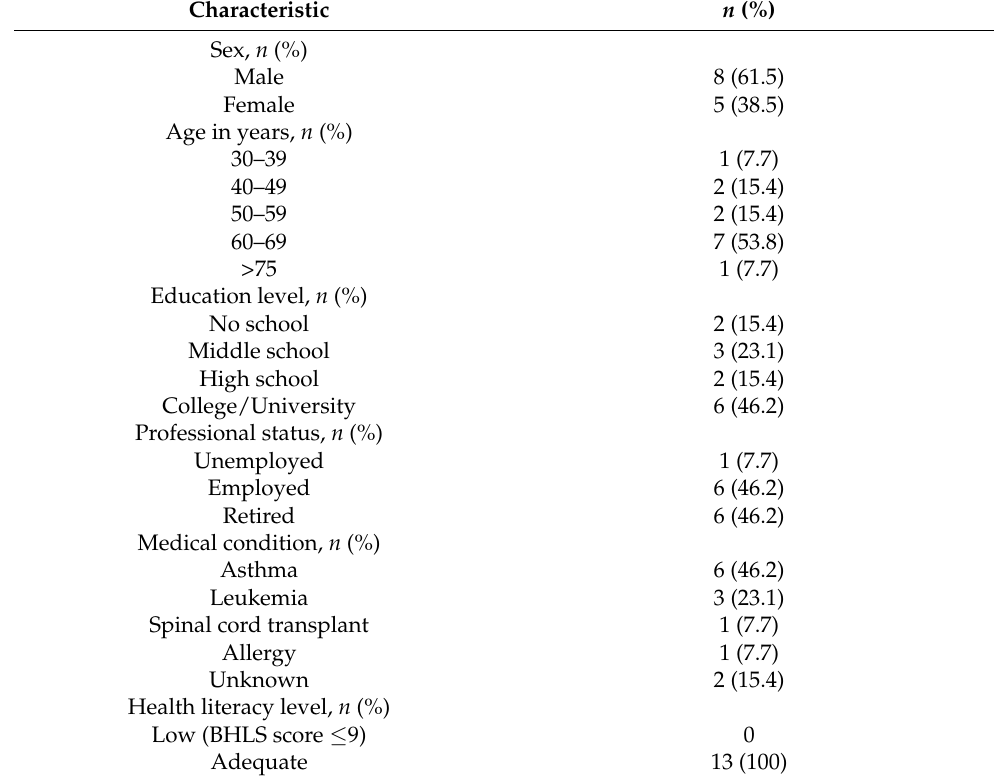
Table 3. Patients